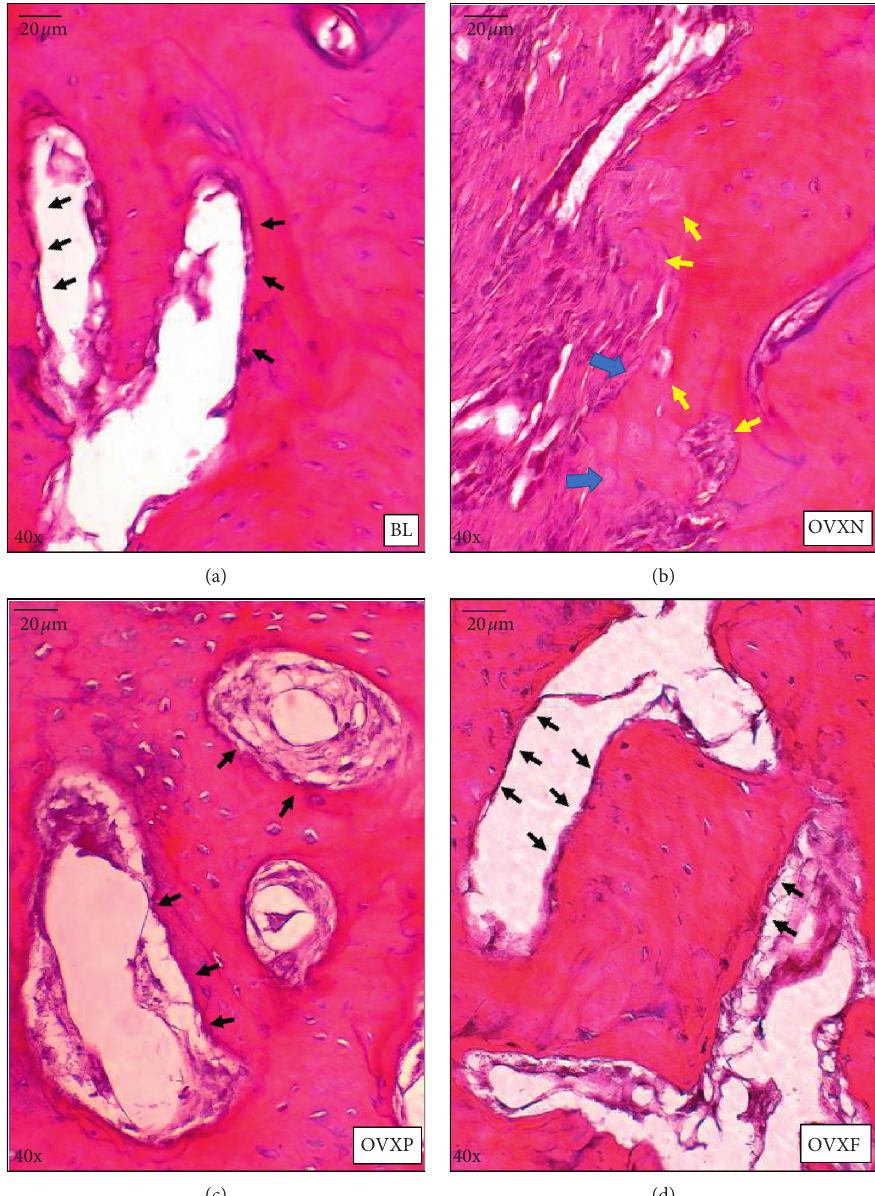
Figure 9: Interradicular septum of the M1 region observed under a light microscope at 40x magnification of (a) baseline rats, (b) OVXN group, (c) OVXP group, and (d) OVXF group. Osteoblasts represented by ; osteoclasts represented by ; and alveolar bone resorption represented by